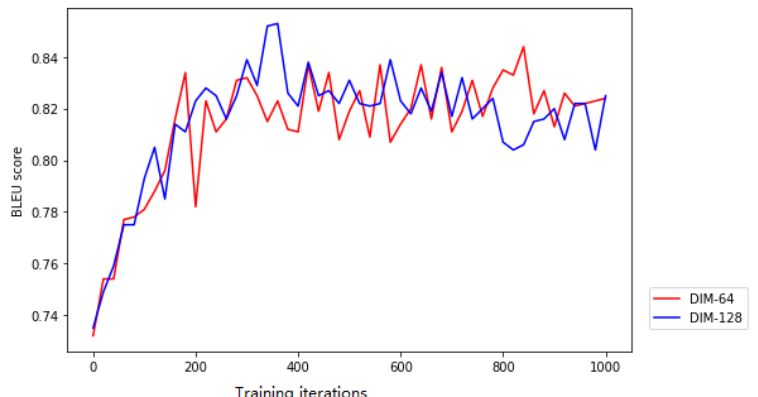
Figure 8. The BLEU-2 scores for the COCO image captions with Dimension = 64 and